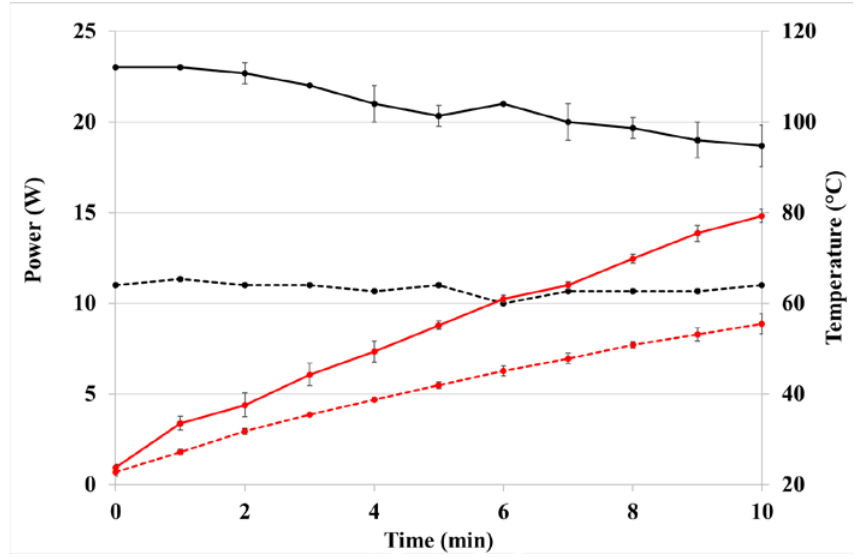
Figure 2. Variation of power (black line) and oil temperature (red line) upon UAE in 50 mL of olive oil using a 2 mm (solid line) or 7 mm (dashed line) probe.